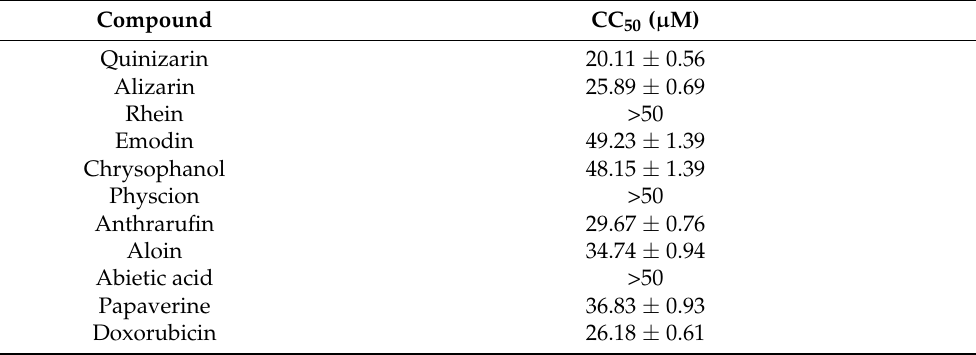
Table 2. CC 50 s of the selected compounds against WI-38 cell